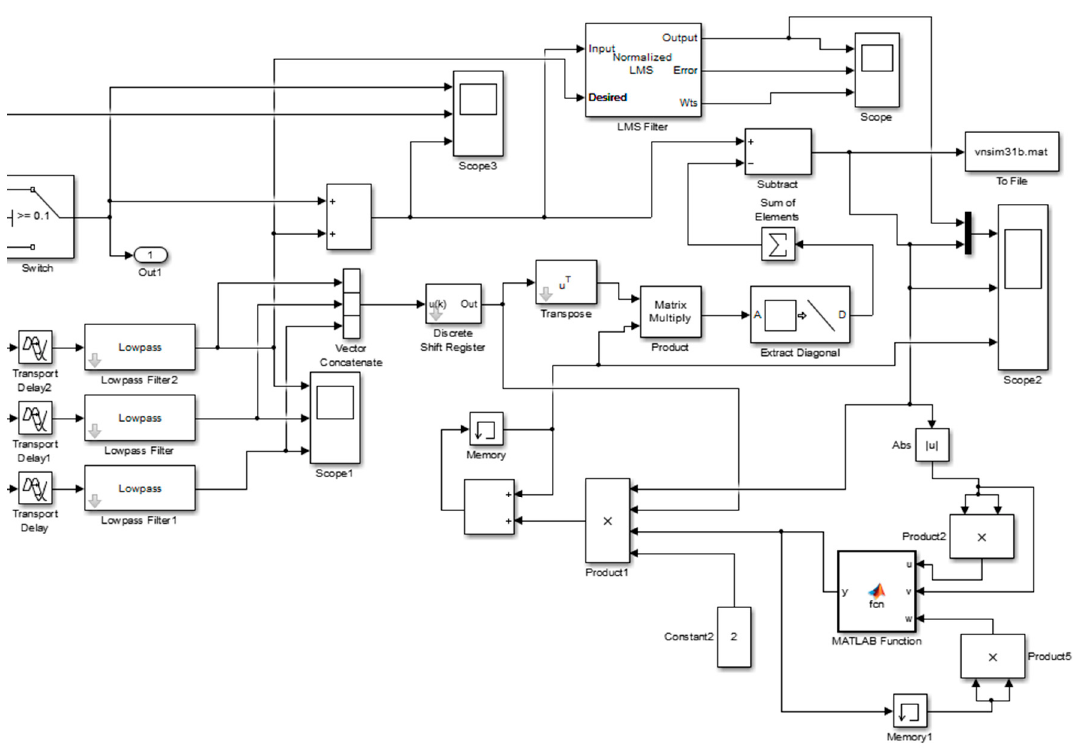
Figure A2. Simulink diagram for multi-channel noise cancellation using the regularized variable step-size LMS (RVSSLMS).